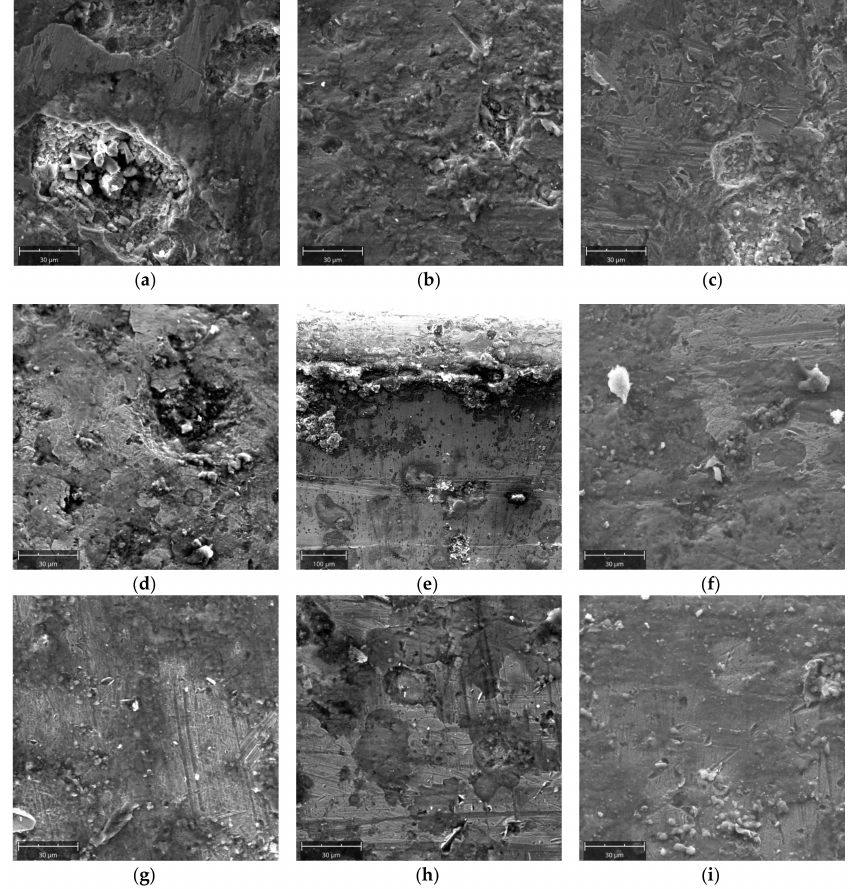
Figure 16. Topography of the abrasion surfaces of molding cavities. Observed on side A. ( a ) First row; ( b ) Third row; ( c ) Fifth row. Observed on side AB. ( d ) First row; ( e ) Third row; ( f ) Fifth row. Observed on side B. ( g ) First row; ( h ) Third row; ( i ) Fifth